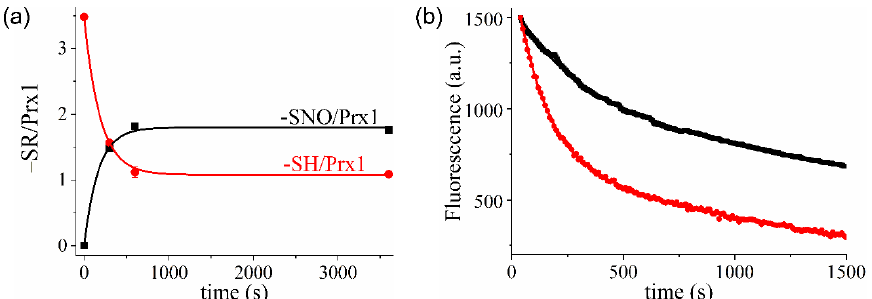
Figure 3. GSNO promotes S-nitrosation of two cysteine residues in wild-type Prx1. ( a ) Time-dependent content of thiol/protein (red trace) and nitrosothiol/protein (black trace) in Prx1 during its reaction with a 80-fold molar excess of GSNO (400 μ M) ( b ) Representative kinetics of the reaction between reduced (red curve) or oxidized (black curve) Prx1 (5 μ M) with GSNO (400 μ M) at pH 7.4 and 25 °C ( λ exc. = 280 nm; λ em. = 330 nm, Hitachi F-2500 fluorimeter).